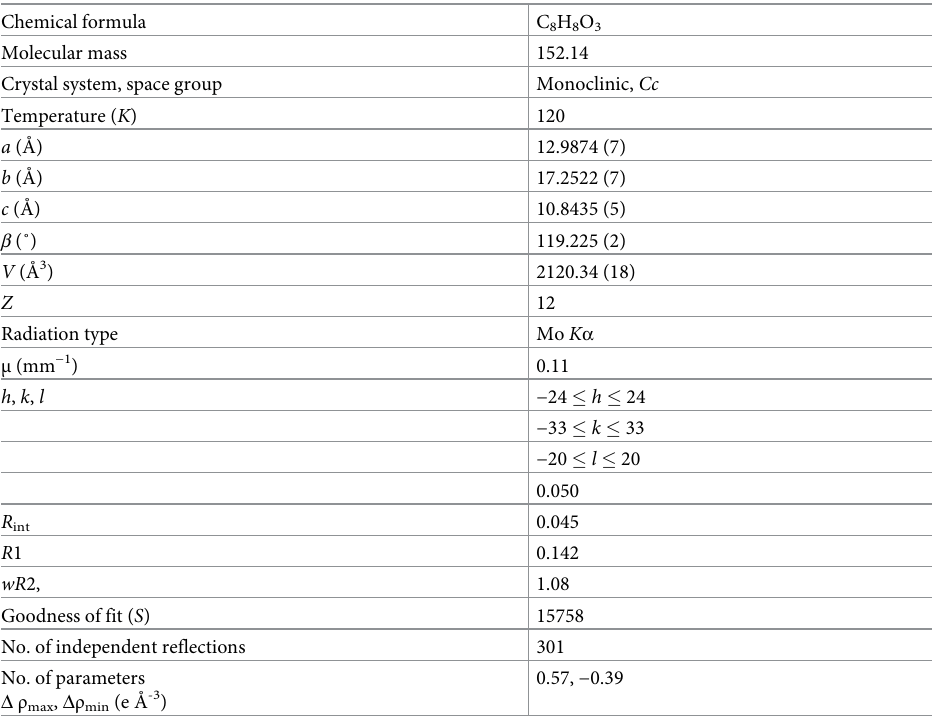
Table 1. The crystallographic data and refinement details.